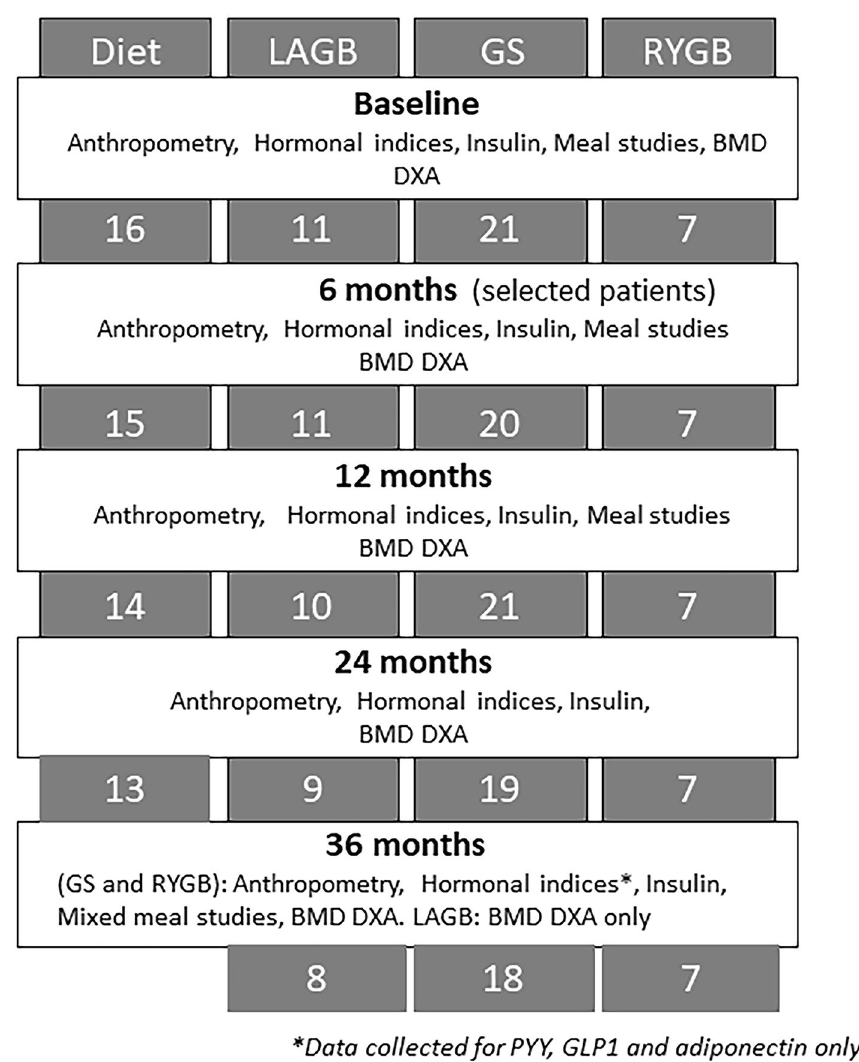
Figure 1. Flow of study participants and study